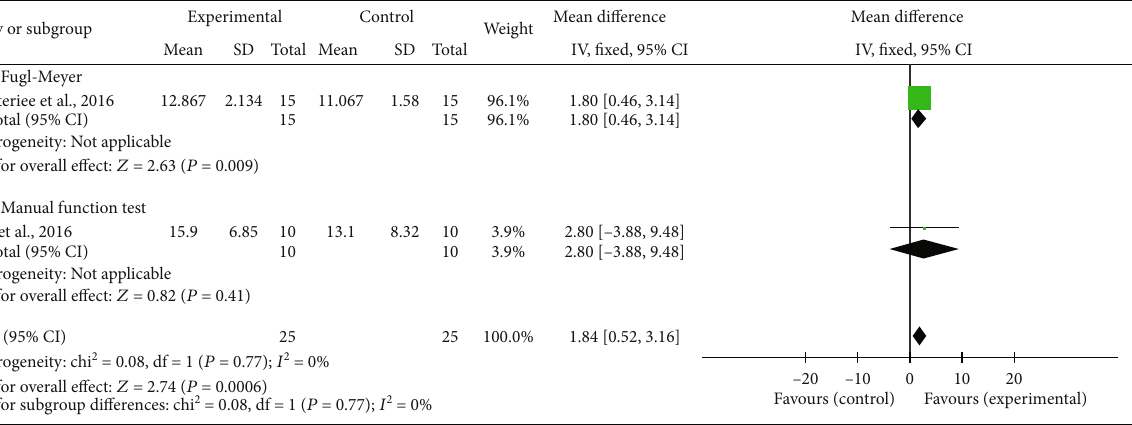
Figure 4: Upper limb function: forest plot of articles that used Fugl-Meyer and manual function test. Legend: SD: standard deviation; CI: con fi dence